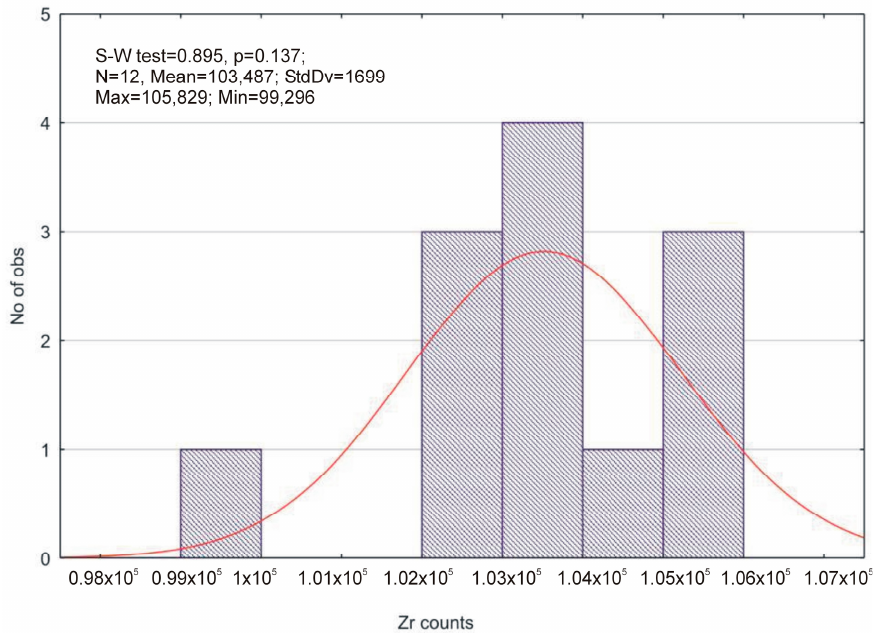
Figure 7. Results of the Shapiro–Wilk test and descriptive statistics.